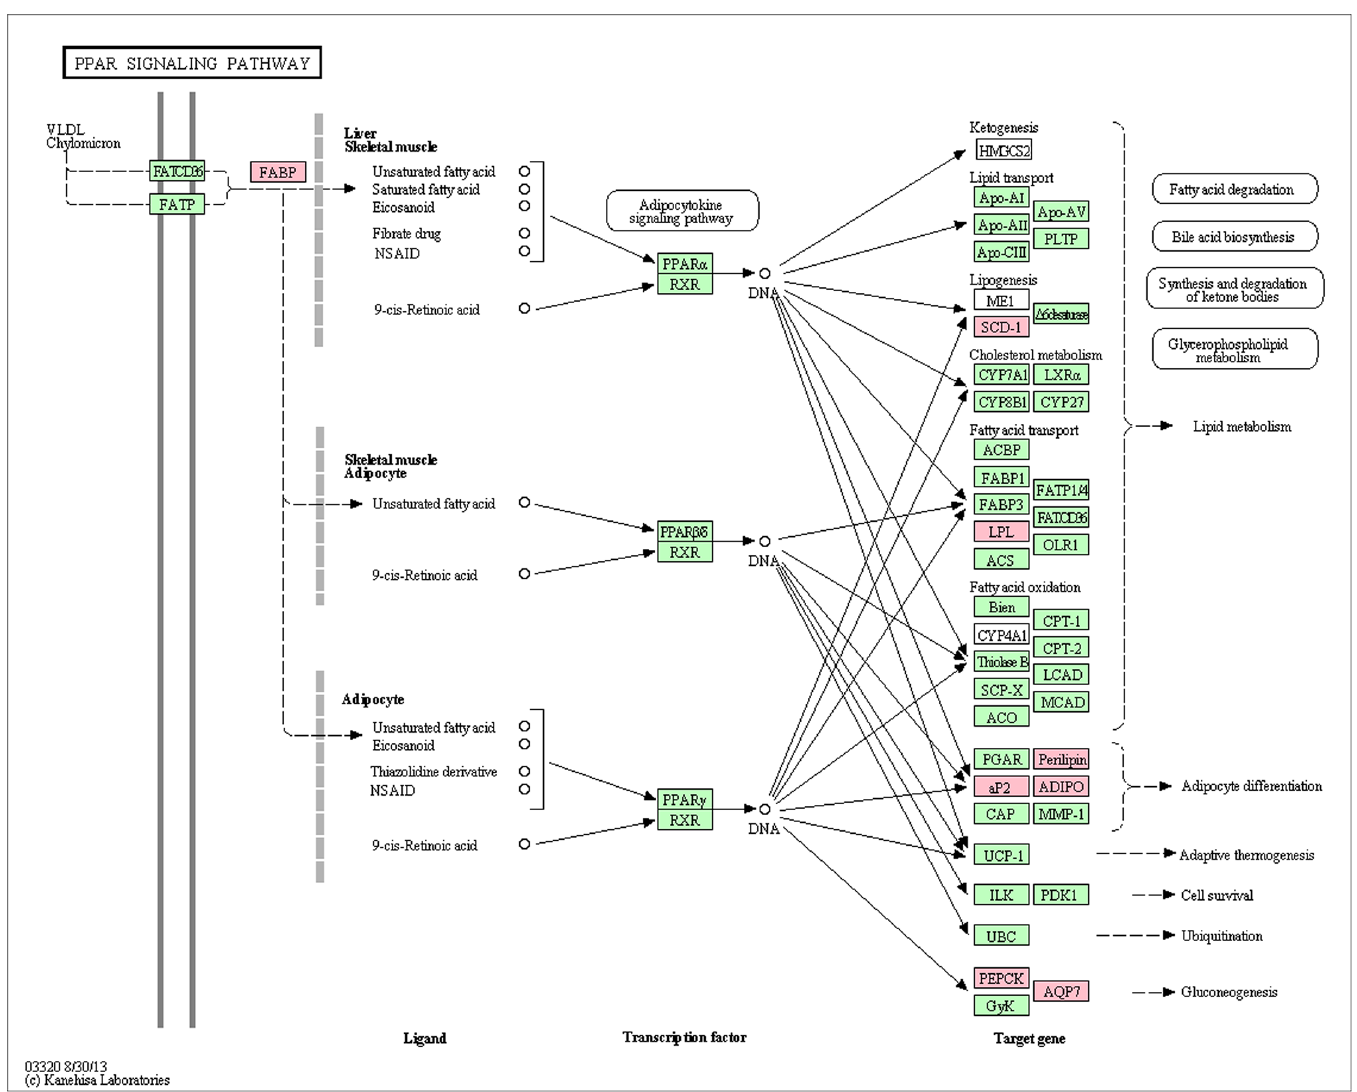
Fig 8. Differentially expressed genes between Stage 0 and Stage 1 of secondary HF morphogenesis involved in PPAR signaling pathway. The red color labels genes significantly down regulated in stage 1 compared with stage 0(q value < 0.005).The green color labels genes were expressed in sheep skin during secondary HF initiation, but not significant